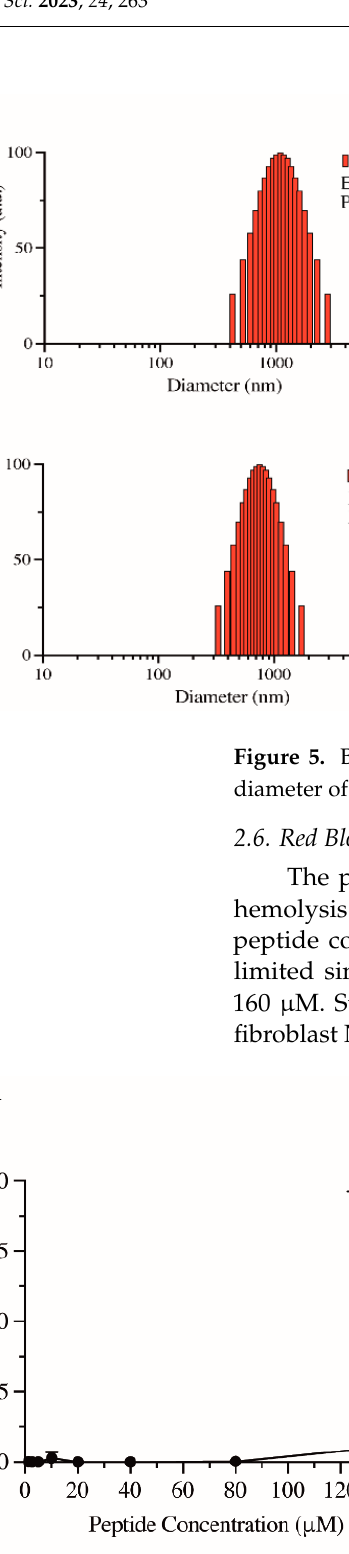
Figure 6. ( A ) Plot showing % hemolysis of RBC as a function of concentrations of cWY6 peptide. ( B ) Bar diagram showing % cell viability of mouse fibroblast cells determined from MTT assays as a function of concentrations of cWY6 peptide.